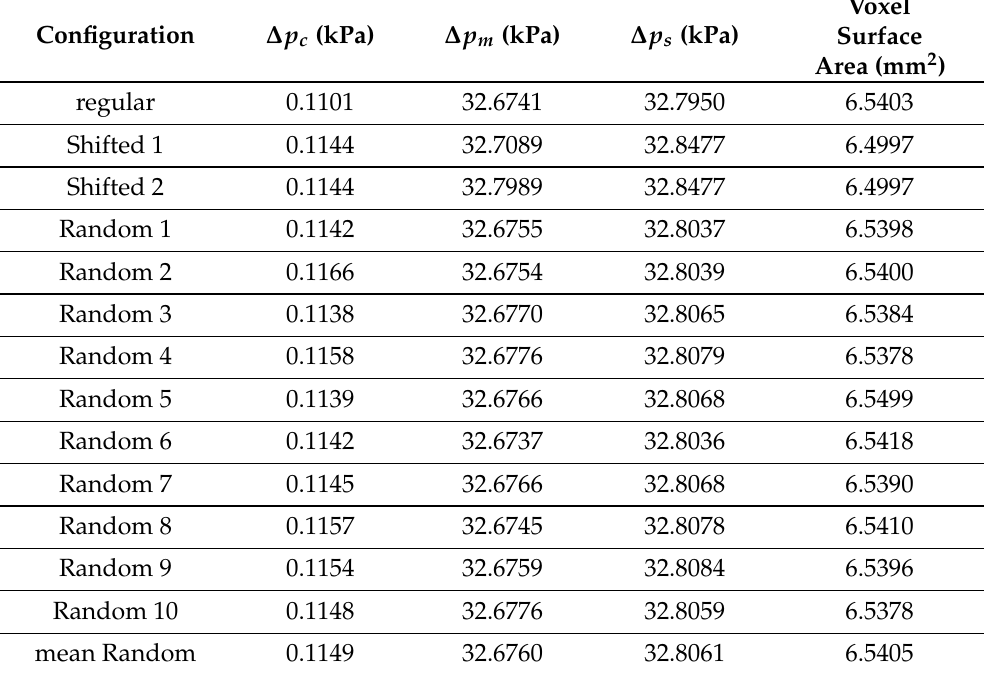
Table 2. Simulation results for idealized microcapsules on the surface of the